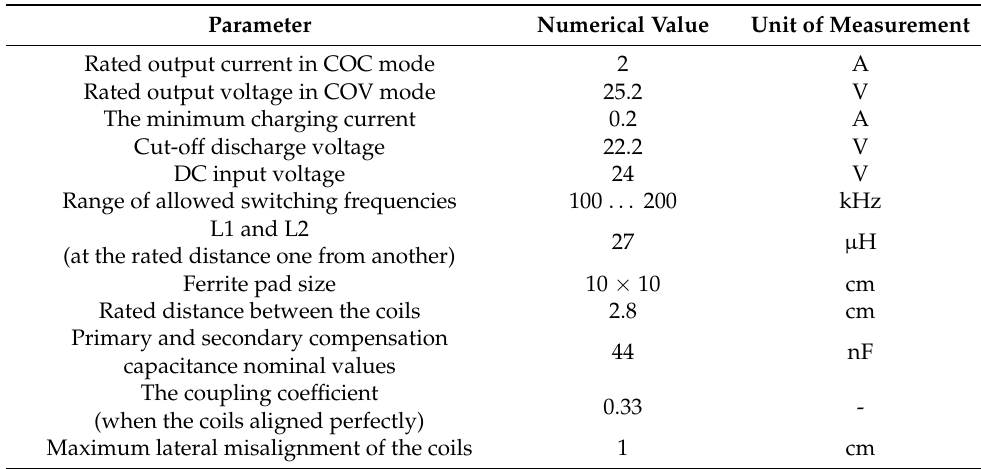
Table 1. The parameters values of the designed wireless battery charger. Parameter Numerical Value Unit of